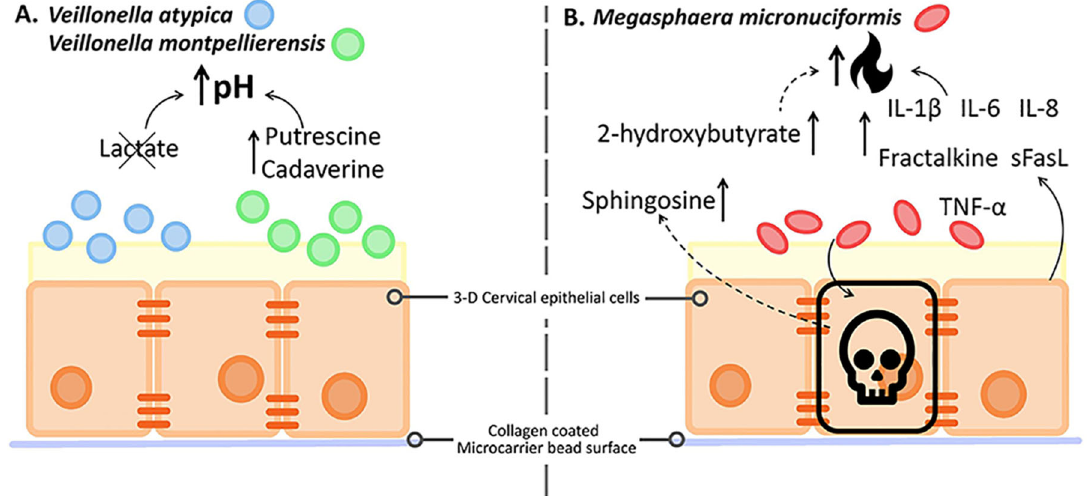
Fig. 6 Members of the Veillonellaceae family uniquely modify the immunometabolic cervical microenvironment. Summary of immunoproteomics and metabolomics analyses of 3-D cervical cells infected with V. atypica, V. montpellierensis or M. micronuciformis . A Lactate was depleted and polyamines (putrescine and cadaverine) are signi fi cantly accumulated in cell culture supernatants of 3-D cervical cells infected with either V. atypica or V. montpellierensis . Lactate (metabolic hallmark of cervicovaginal health) depletion and elevated polyamine levels may correspond with an increase in pH, a clinical hallmark of BV. B The SCFA 2-hydroxybutyrate was signi fi cantly accumulated in the cell culture supernatants of 3-D cervical cells infected with M. micronuciformis . In addition, several pro-in fl ammatory mediators were elevated following infection with M. micronuciformis , including IL-1 β , IL-6, IL-8, Fractalkine, sFasL, TNF- α . Finally, cytotoxicity/viability analyses revealed that M. micronuciformis infection resulted in moderate cervical epithelial cell death, as well as enrichment of sphingosine that could suggest the induction of cell death. Overall, M. micronuciformis may promote a pro-in fl ammatory immune pro fi le within the cervical microenvironment, and cause cervical epithelial cell damage, compared to both Veillonella